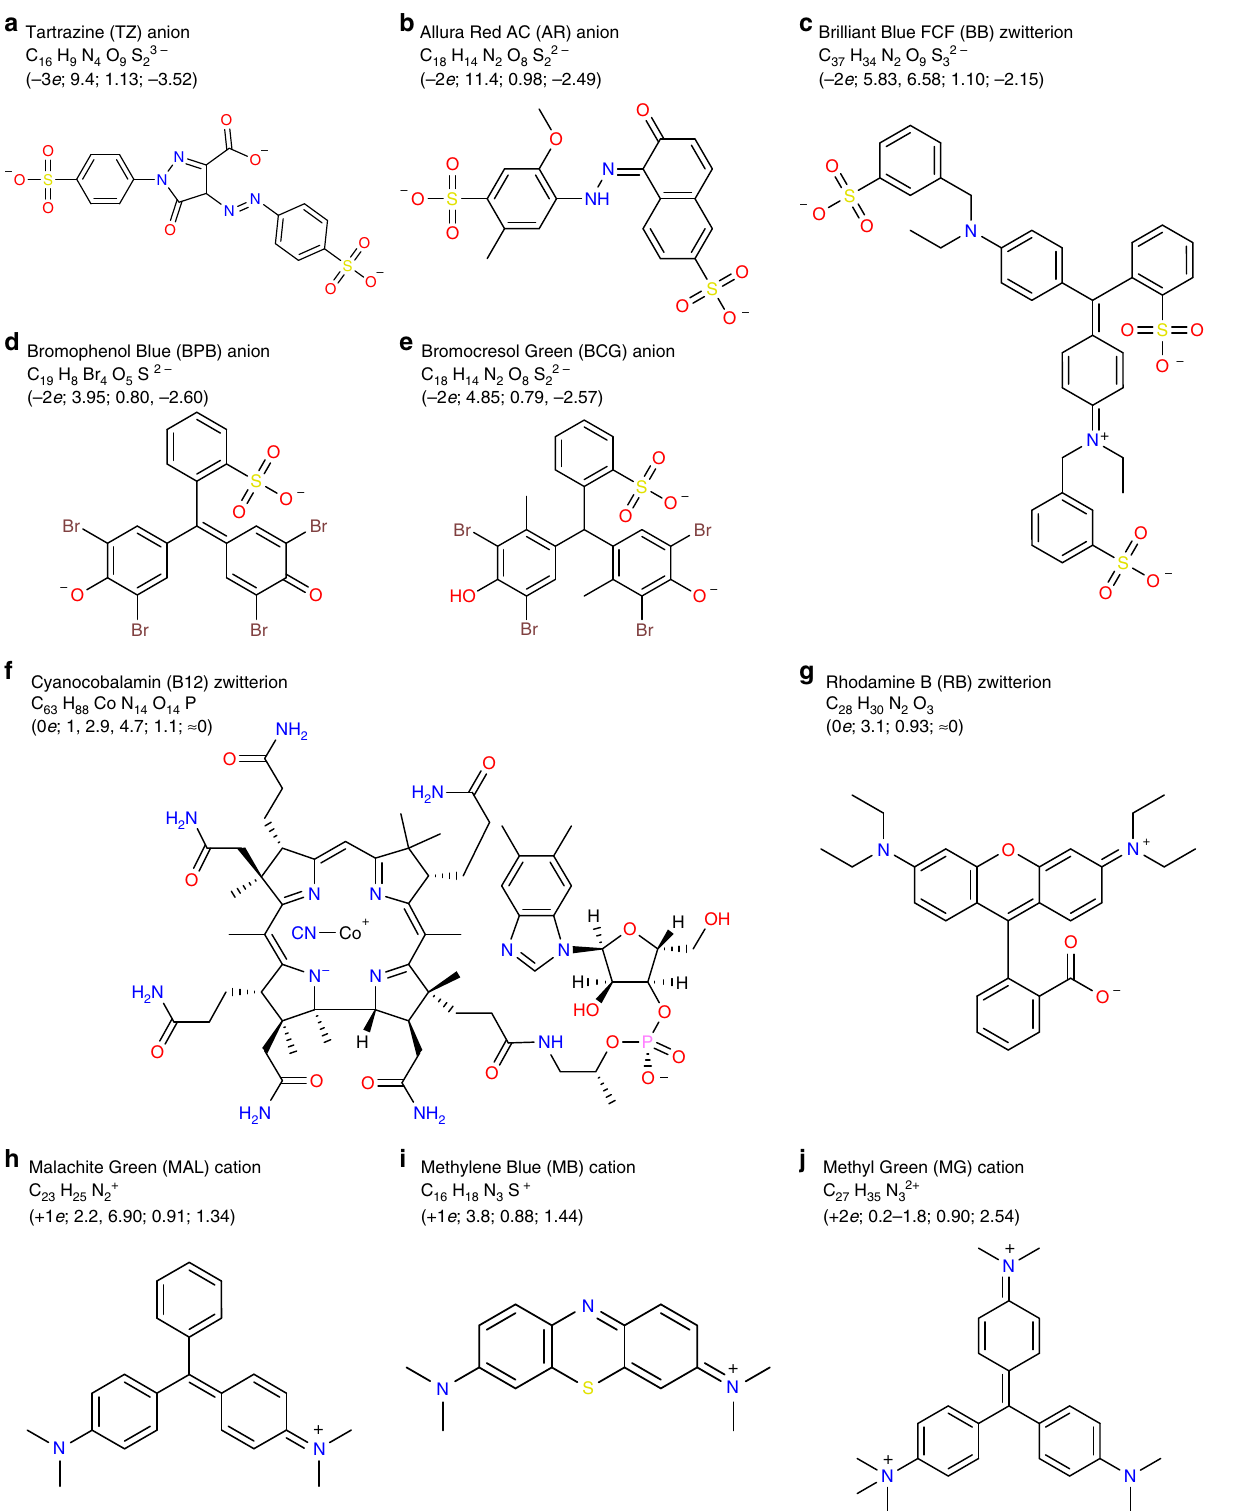
Fig. 2 Structural diagrams and properties of organic dyes at pH = 9. a Tartrazine (TZ) anion, 465.39 g mol − 1 . b Allura Red (AR) anion, 450.44 g mol − 1 . c Brilliant Blue FCF (BB) zwitterion, 746.87 g mol − 1 . d Bromophenol Blue (BPB) anion, 667.95 g mol − 1 . e Bromocresol Green (BCG) anion, 698.02 g mol − 1 . f Cyanocobalamin FCF (B12) zwitterion, 1,355.39 g mol − 1 . g Rhodamine B (RB) zwitterion, 442.56 g mol − 1 . h Malachite Green (MAL) cation, 329.47 g mol − 1 . i Methylene Blue (MB) cation, 284.40g mol − 1 . j Methyl Green (MG) cation, 387.57 g mol − 1 . Values in parentheses at the upper left of each panel provide predicted nearest integer charge q ( e ); translational hydrodynamic radius a (in nm); and measured electrophoretic mobility μ e,meas (in 10 − 8 m 2 V − 1 s − 1 ). Below this, we list reported p K a value(s) or range(s) from literature sources (see Supplementary Methods). Charges are approximate, and have been rounded to the nearest integer (see Supplementary Methods). Estimates of equivalent hydrodynamic sphere radii are made using WinHydroPro and HyperChem (see the Methods section). Corresponding minimized molecular models from HyperChem are shown in Supplementary Fig. 1 NATURE COMMUNICATIONS| (2019) 10:3631